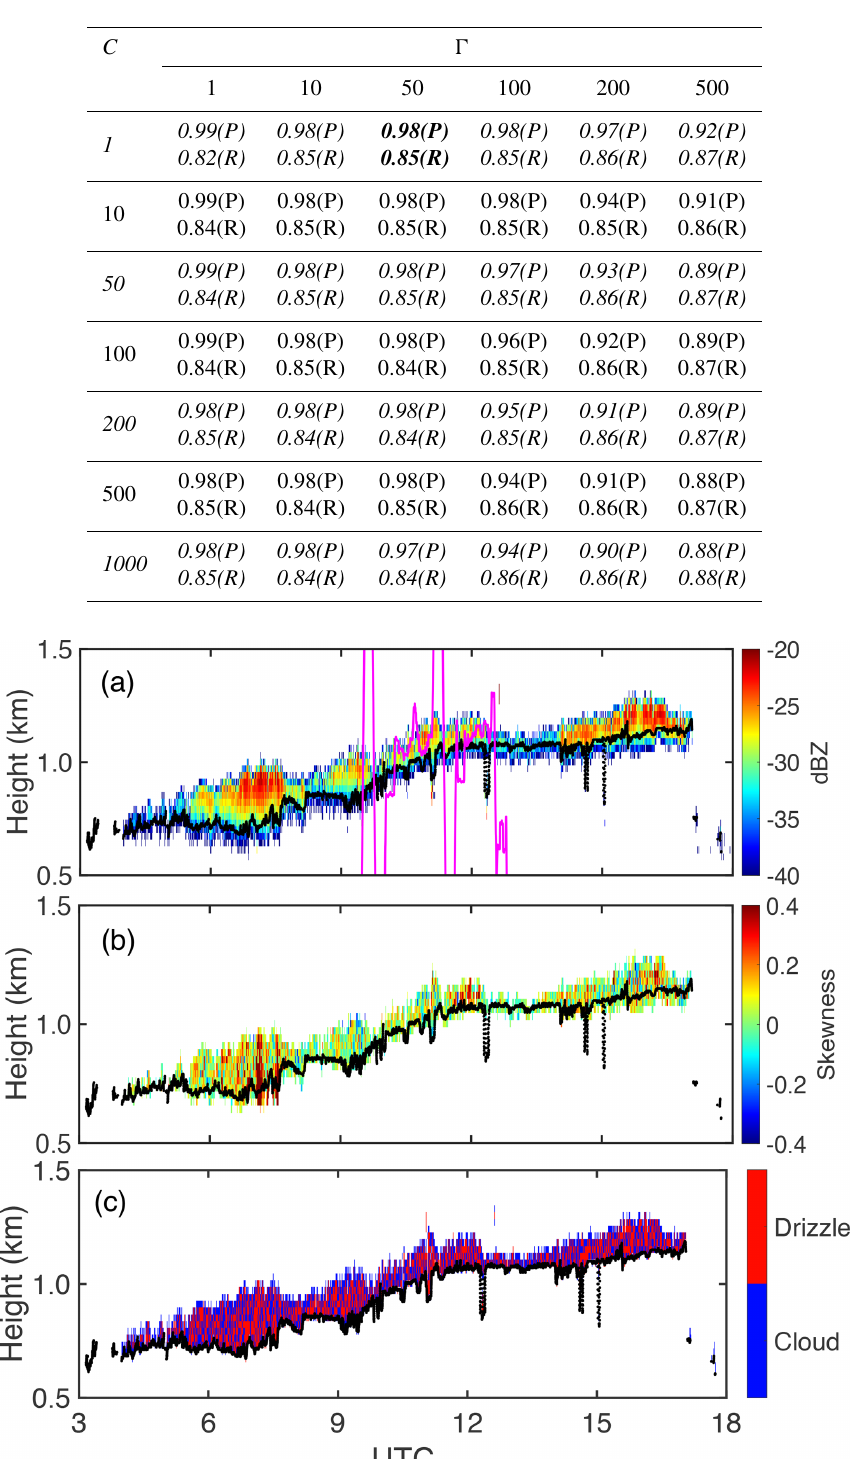
Table 1. Precision (P) and recall (R) of the drizzle/cloud classification outcomes for different combinations of C and (cid:48) . The values shown in bold italics represent the classification performance obtained for the parameters used in this study.